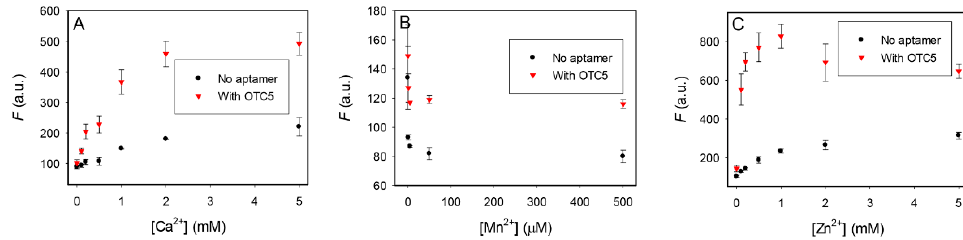
Figure 6. The fluorescence of 100 nM OTC alone and with 2 μ M OTC5 aptamer as a function of ( A ) Ca 2+ , ( B ) Mn 2+ , and ( C ) Zn 2+ concentration. All the experiments were run in pH 6.0 MES